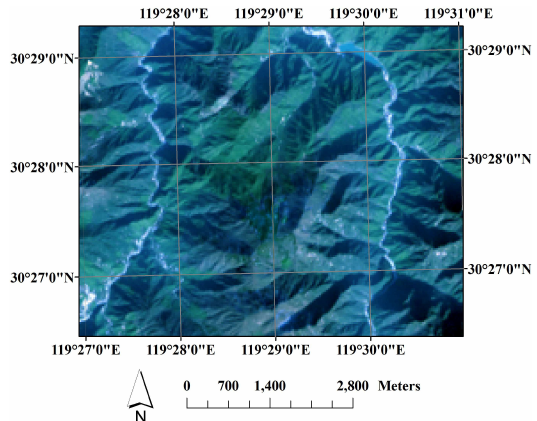
Figure 2. Location of the study area in the north of Anji County, Zhejiang, China.